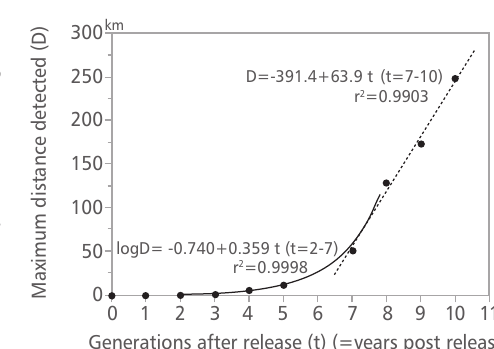
FIGURE 2. Range expansion of Torymus sinensis , relationship between the number of generations (t) after the release in Japan (Tsukuba) in 1982 and maximum distance (D) from the release site to the locality where T. sinensis has been detected (source Moriya et al. [22, of number of infested leaves and shoots. The galls are decreasing in numbers and vegetative growth of chestnut trees is recovering [25].